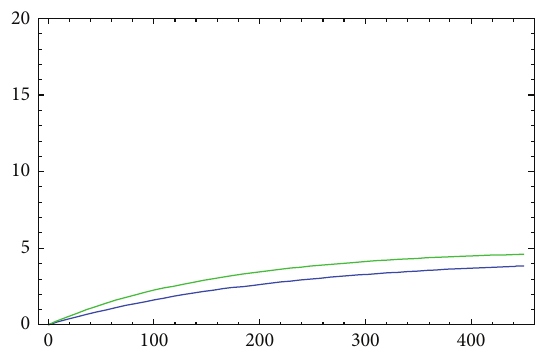
Figure 2: Approximation to the equilibrium point with the order 𝛼